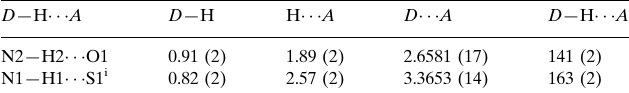
Hydrogen-bond geometry (A˚ , (cid:1)